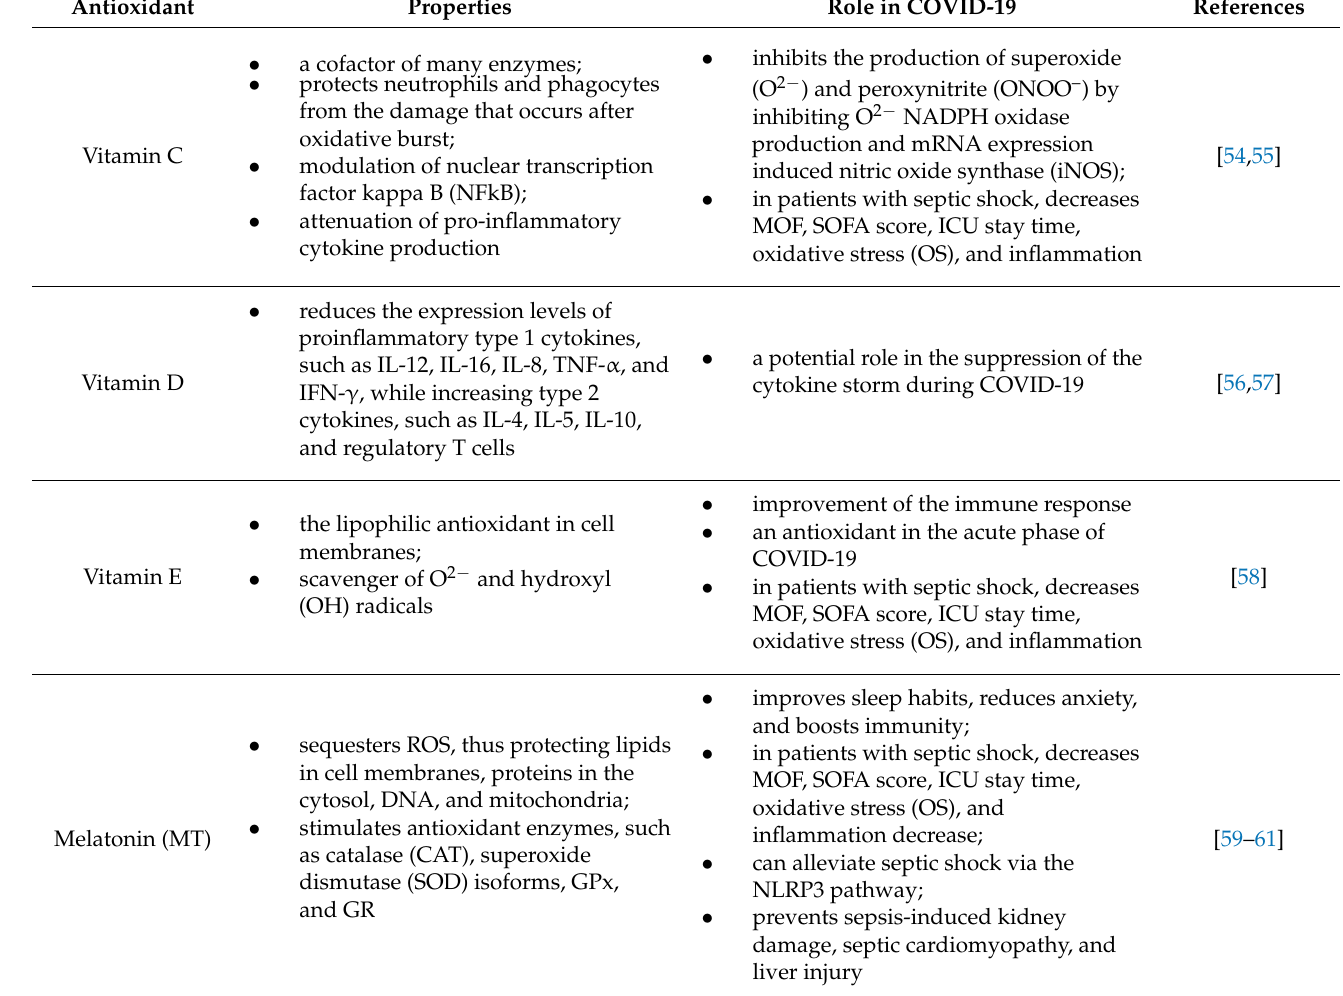
Table 2. The role of selected antioxidants in the course of